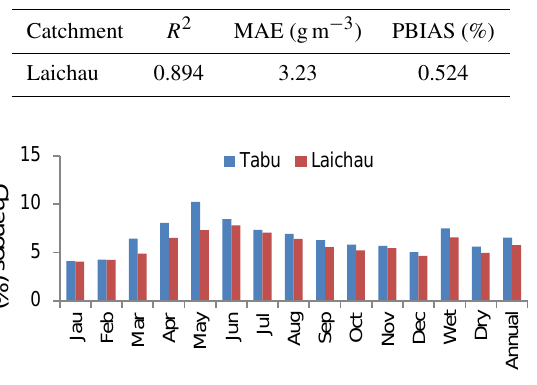
Figure 8. Changes in streamflow under land cover change in 2050 at Laichau and Tabu station.